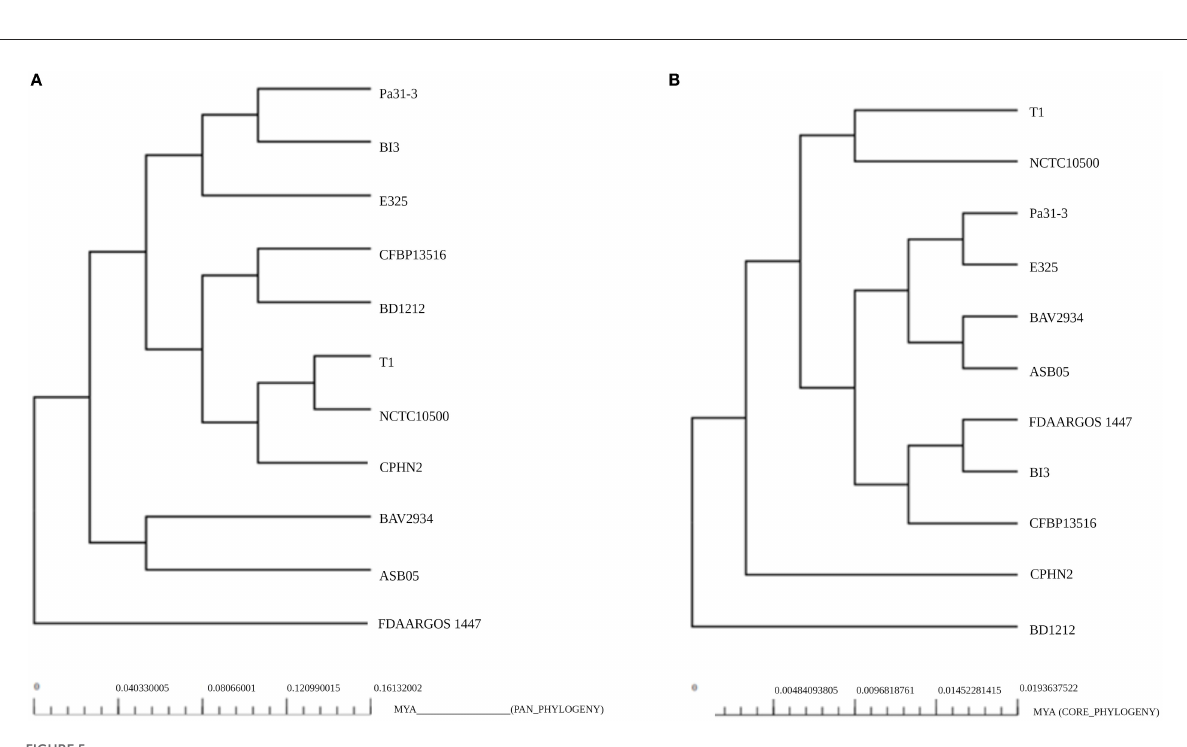
phn gene cluster. CPHN2 has numerous phn genes, including phn CDFGHIJKLMNOPRV, which catalyze the hydrolysis of phosphonate into phosphate and an alkane, according to genomic analysis. Phosphorus compounds must be